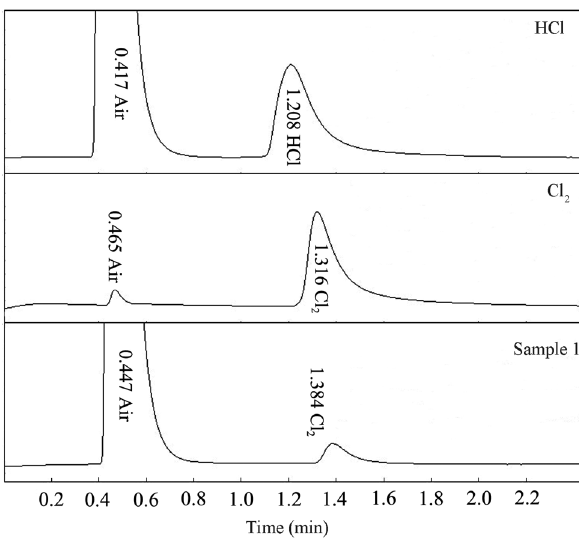
Fig. 8: GC chromatograms of gas sample obtained under atmosphere of air